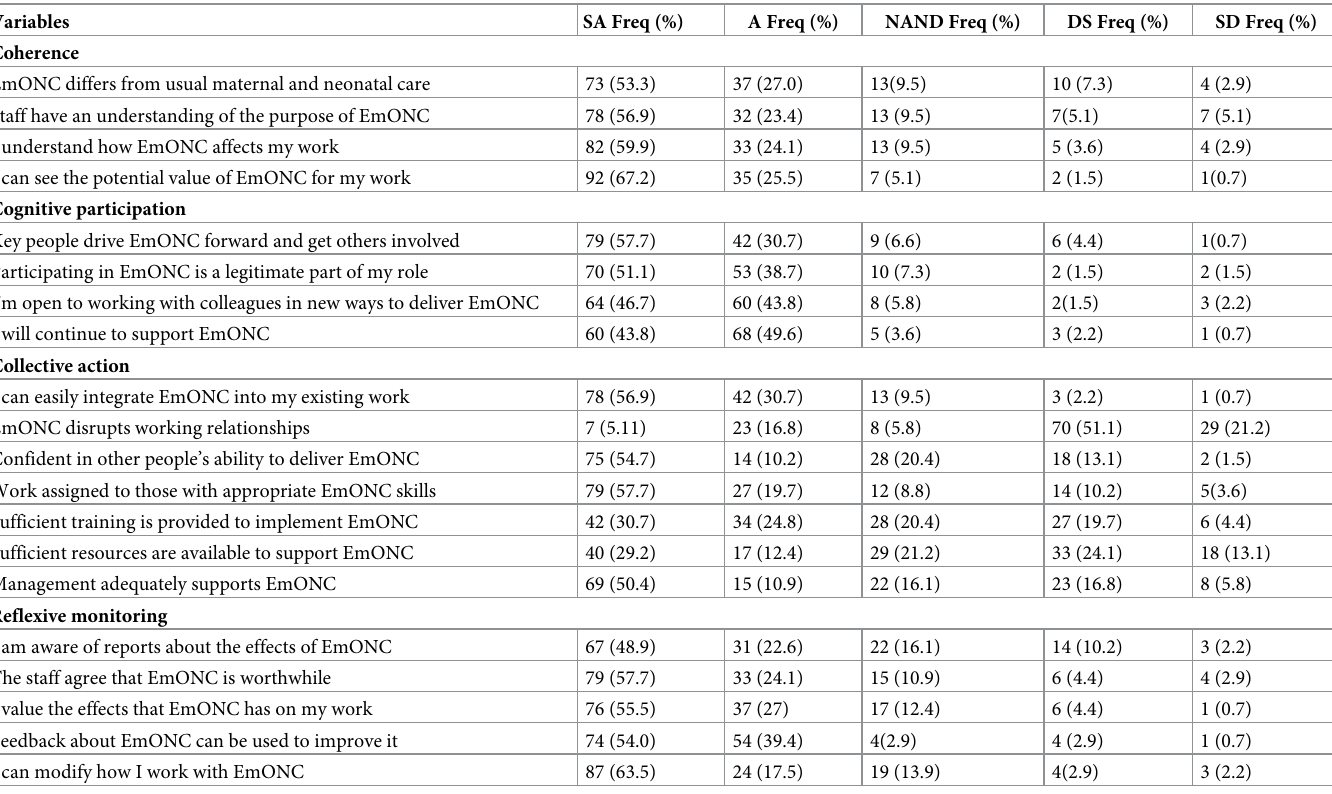
Table 4. Mechanism of integration of EmONC into maternal and newborn care in tertiary healthcare facilities (n =